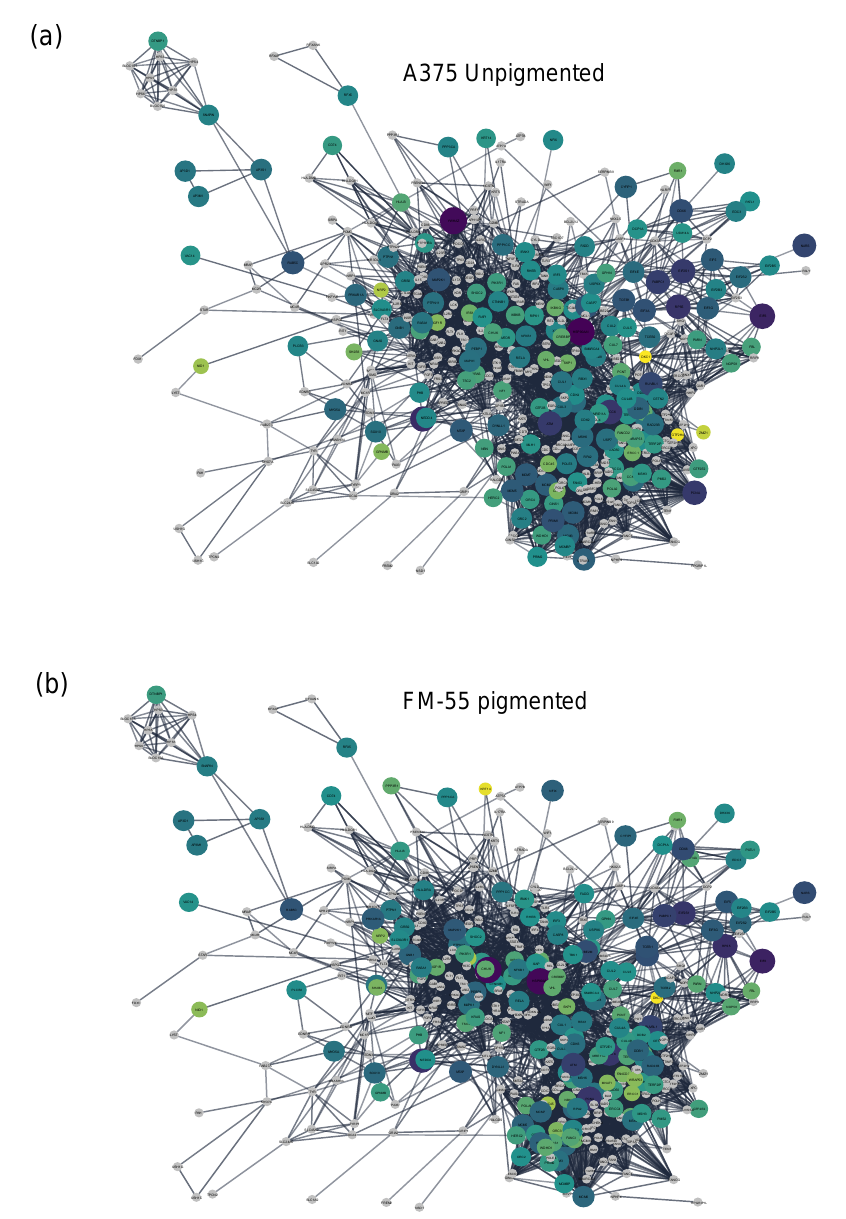
Figure 5. Quantitative pigmentation network map in two melanoma cell lines. ( a ) Expanded pigmentation network with protein shape and color following their expression levels in the unpigmented A375 cell line. ( b ) Expanded pigmentation network with protein shape and color following their expression levels in the FM55 pigmented cell line. The nodes are colored according to the log transformed LFQ intensity yellow = low, dark blue = high. The size of the node is also set according to the log transformed LFQ.